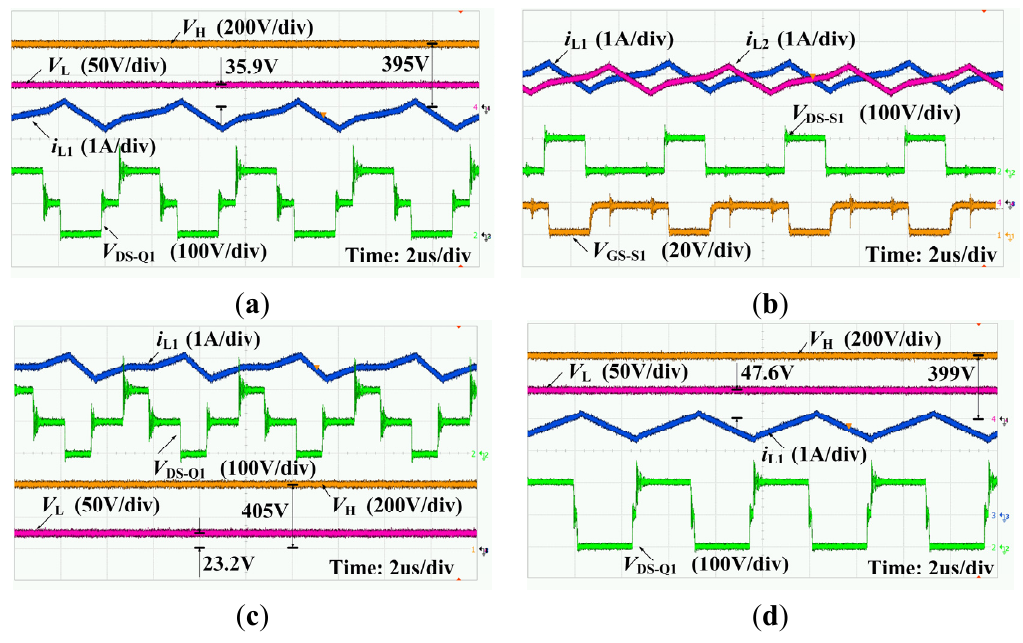
Figure 17. Experimental waveforms under CCM Boost mode ( a ) and ( b ) 36 V to 400 V; ( c ) 24 V to 400 V; ( d ) 48 V to 400